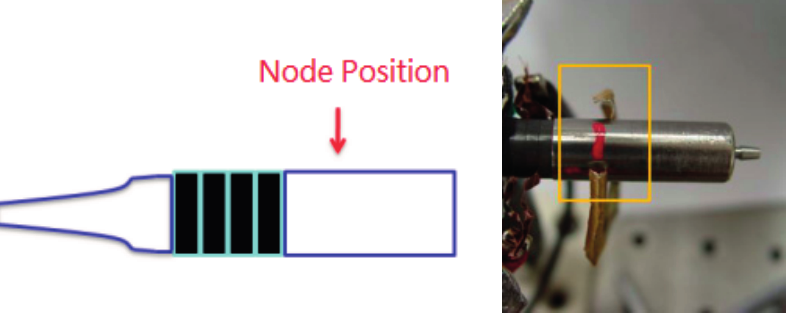
Figure 3. The node position of the ultrasonic dental handpiece.